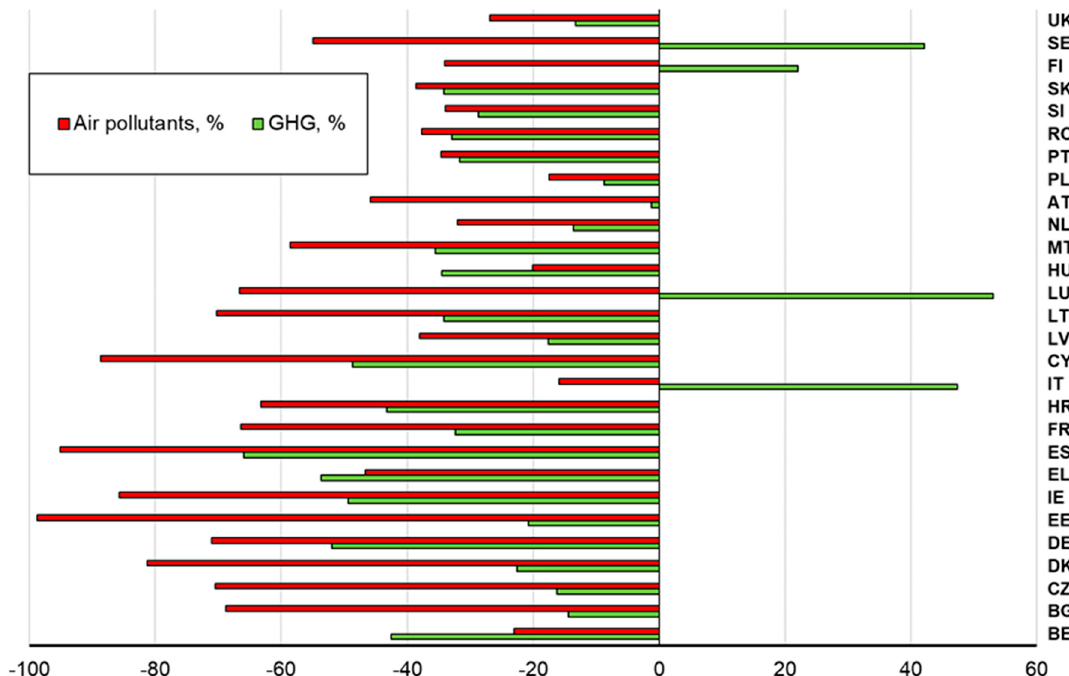
Figure 5. Changes in the emissions of studied greenhouse gases (CO 2 , CH 4 and N 2 O) and air pollution by the mining and quarrying sector in the EU countries in 2008 and 2017 (GHG-greenhouse gases, BE-Belgium, BG-Bulgaria, CZ-Czech Republic, DK-Denmark, DE-Germany, EE-Estonia,